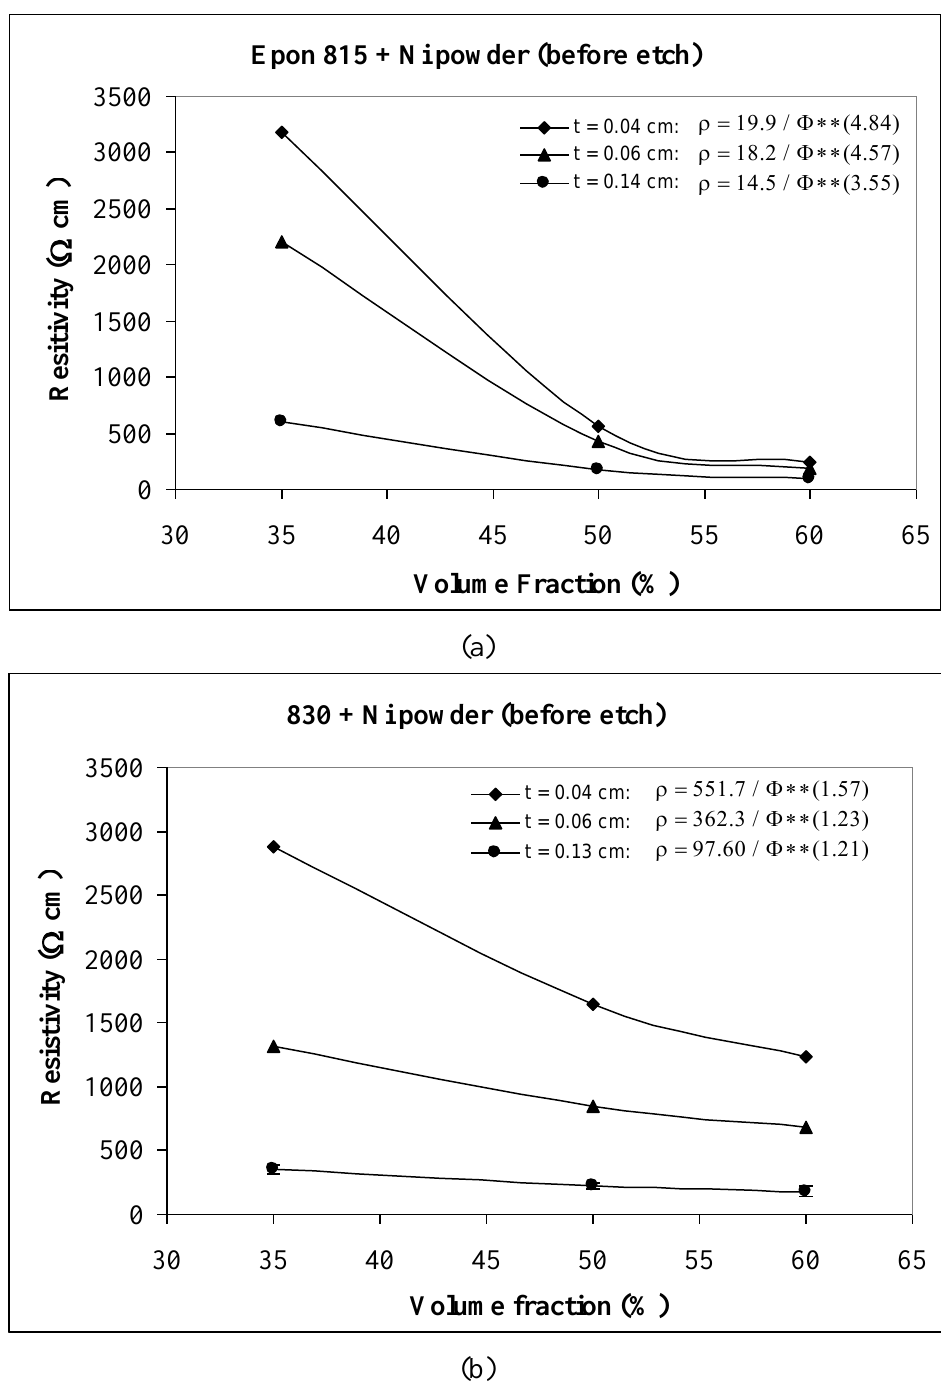
Figure 14. Volume fraction-thickness dependent resistivity of Epon 815C ( a ), and 830 ( b ) films filled with unetched nickel